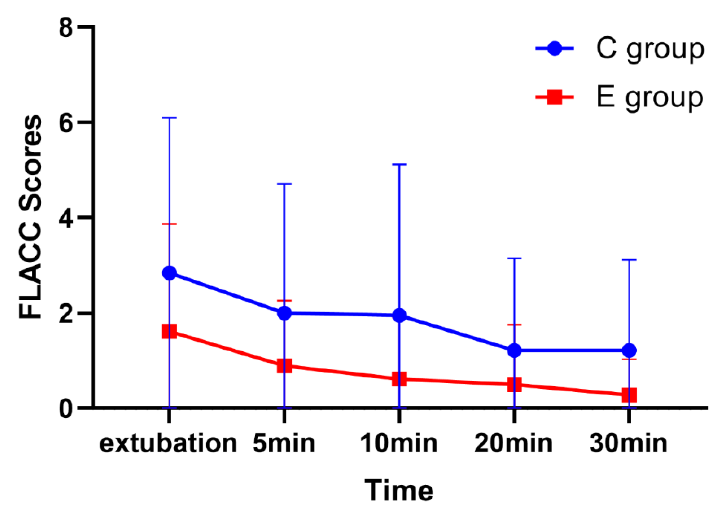
Figure 5. FLACC scores at different time points. FLACC, Faces, Legs, Activity, Cry, and Consolability.